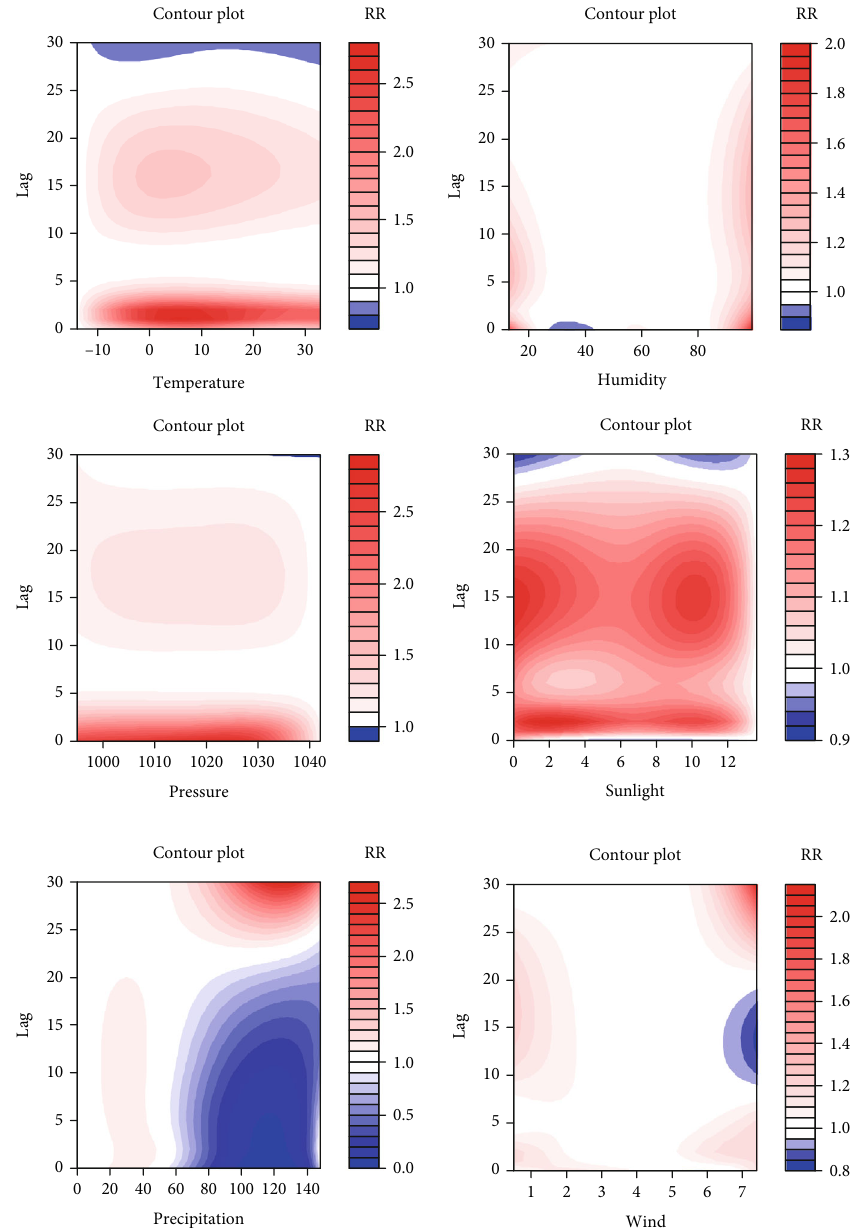
Figure 7: Contour plot of the relationship between meteorological factors and diabetes